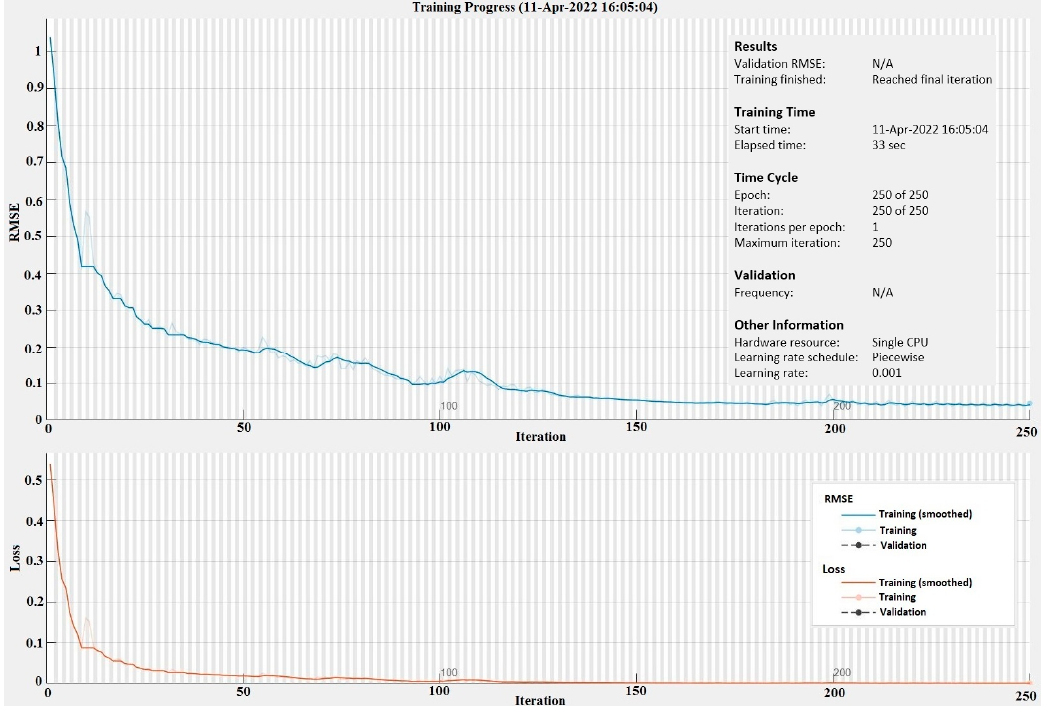
Figure 15. Training progress representation for per-day forecasting using LSTM based DNN.